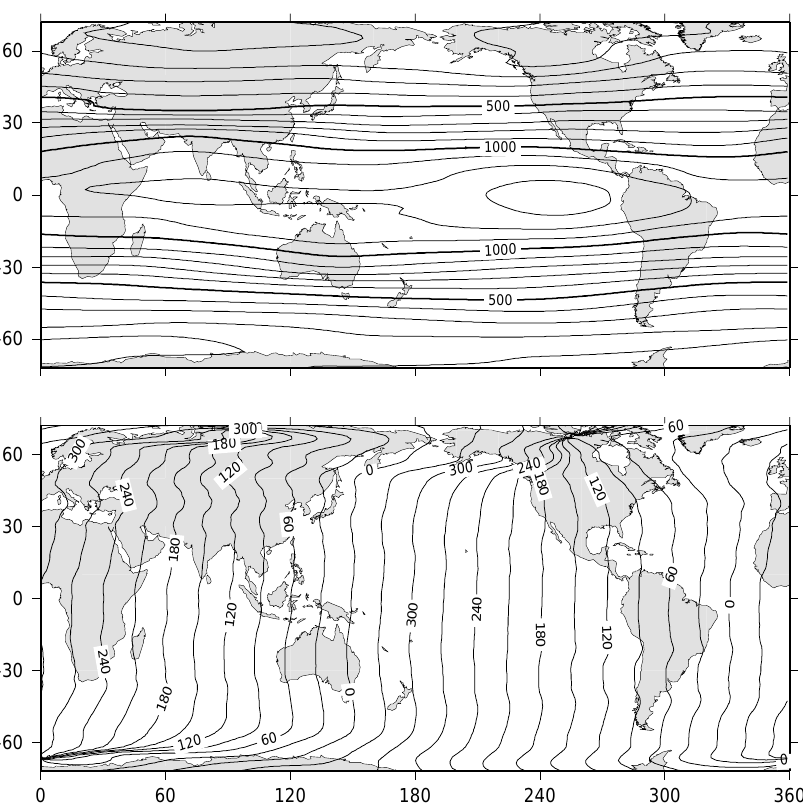
Fig. 5. Amplitude ( µ b) and Greenwich phase lags (degrees) of the S 2 (p) tide, calculated as described in the text. The phase contour interval of 30 ◦ corresponds to 1h in